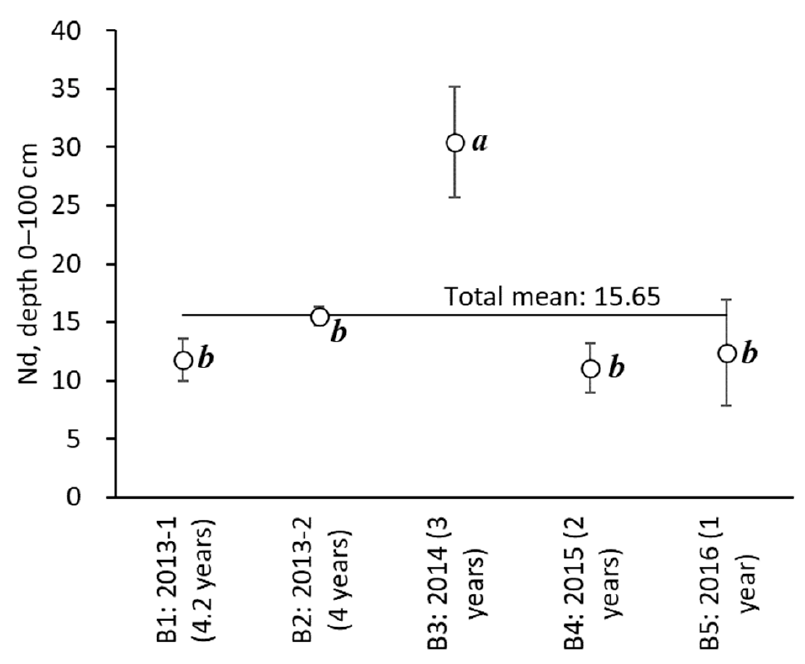
Figure 10. Main effect of Factor B, fiscal year of construction, of Site 1, on the N d -value. The error bars and different letters have the same meaning as in Figure 9. p < 0.01, n = 25 except for B3 ( n = 20).